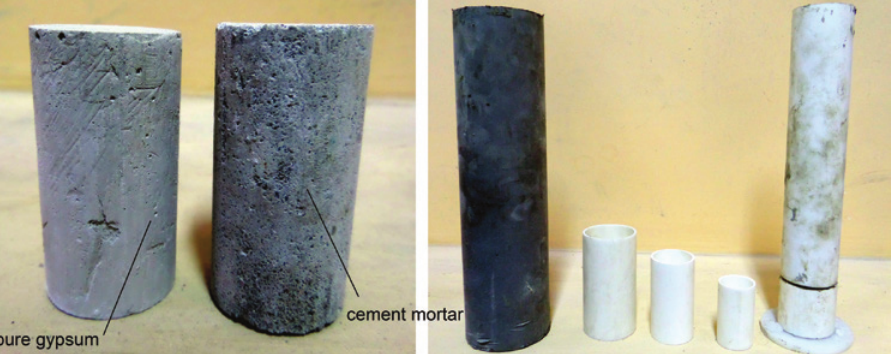
Figure 2: Twenty-eight millimetre samples of gypsum plaster and mortar after removing from cylinders (before the treating procedure) and PCV forms used for preparation of the composites.